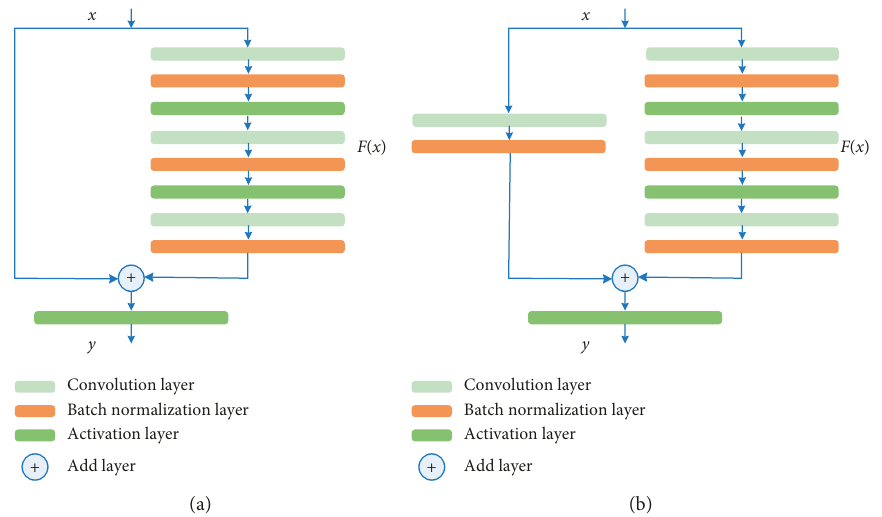
Figure 2: Two types of blocks. (a) identity_block. (b) conv_block.